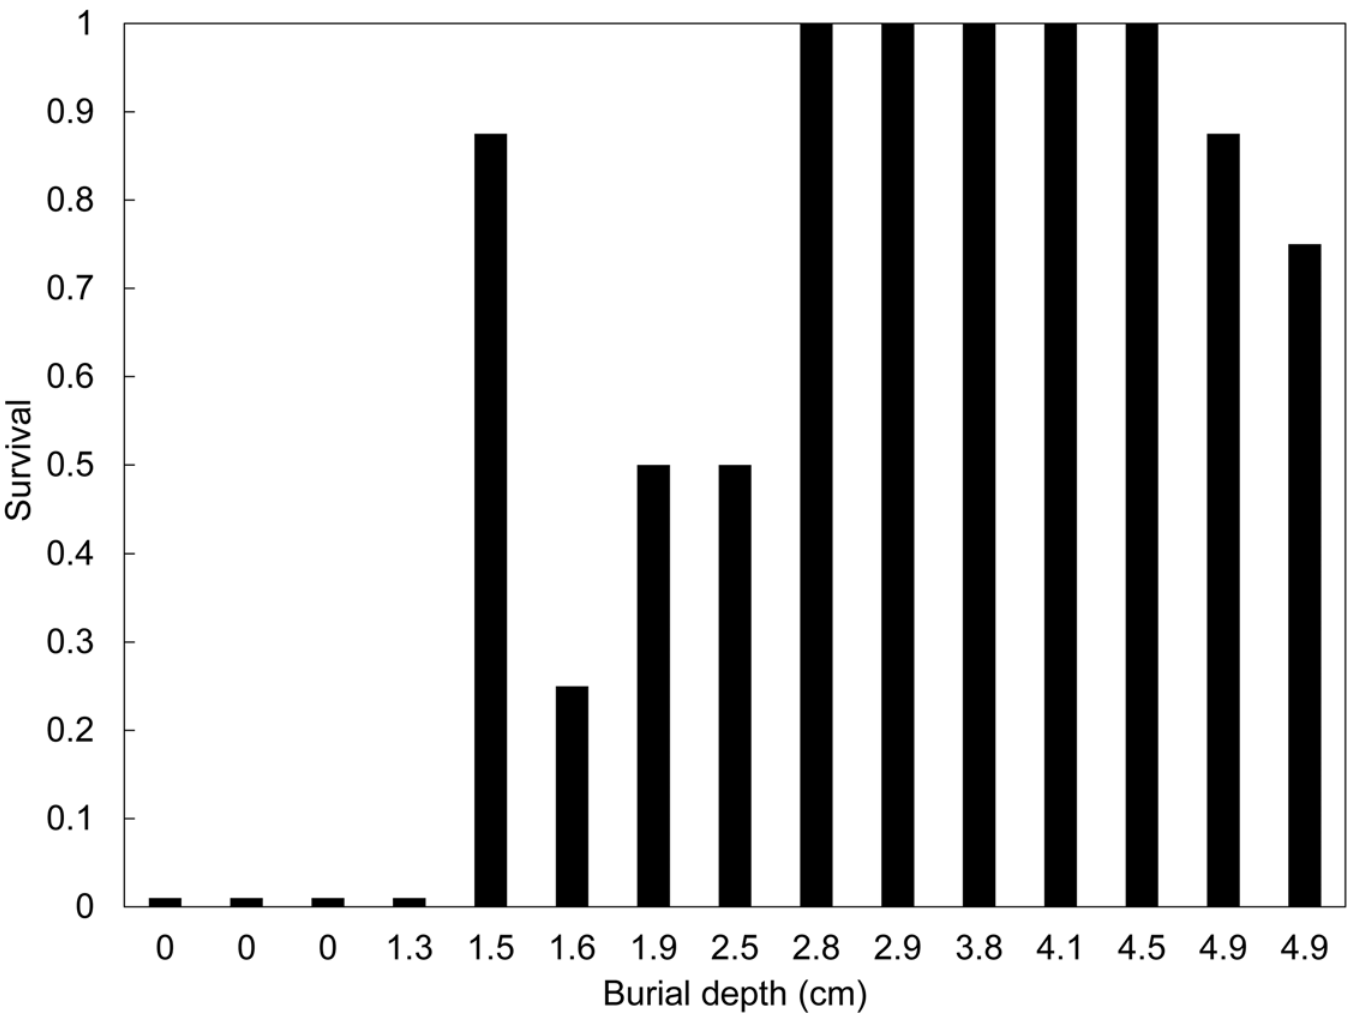
Fig 4. Proportion of E . atala pupae successfully eclosing following controlled burning on July 5 th -6 th at the Ordway Swisher Biological Station, Putnam County, Florida. For each burial depth, n = 8